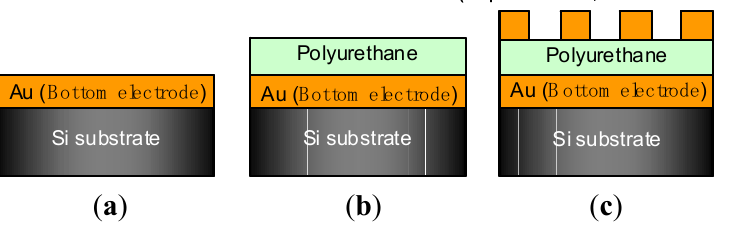
Figure 8. Fabrication process of tactile sensors using polyurethane thin film. ( a ) Evaporation of Au film on Si substrate; ( b ) Spin-coating and etching back of polyurethane; ( c ) Evaporation of Au film through shadow mask.